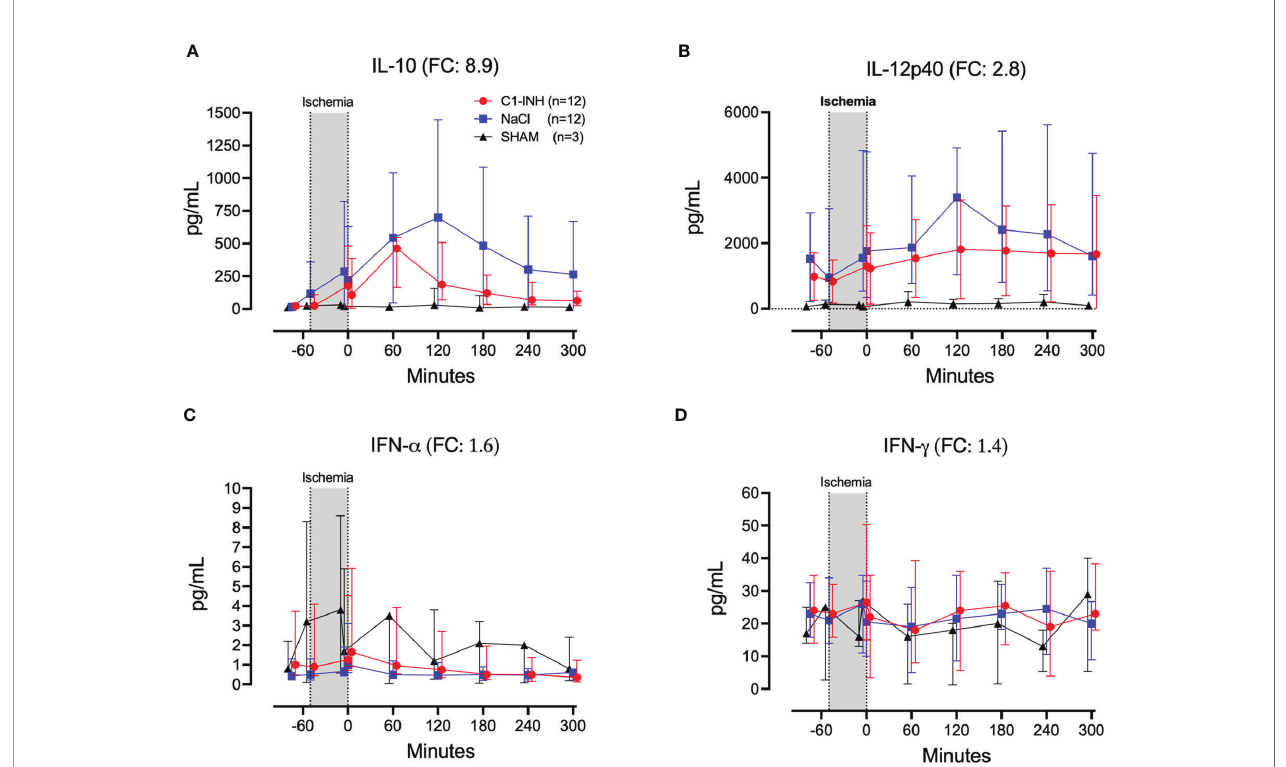
FIGURE 6 | Regulatory cytokines and interferons. (A) Interleukin (IL)-10, (B) IL-12p40, (C) interferon (IFN)- a , and (D) IFN- g were measured in plasma of 24 piglets undergoing clamping of the thoracic aorta at the Th8 level. Upfront 12 piglets received human saline intravenously and 12 received C1-INH (250 IU/kg), respectively. Three sham animals received thoracic opening without clamping. Reperfusion started at 0 minutes and lasted 5 hours. Longitudinal time data are expressed as median and interquartile range. “ Ischemia ” indicates the 45 minutes period of clamping. NaCl and C1-INH-groups were combined when there were no differences in the fold change (FC) calculation. FC is the change from before cross-clamp onset to maximum